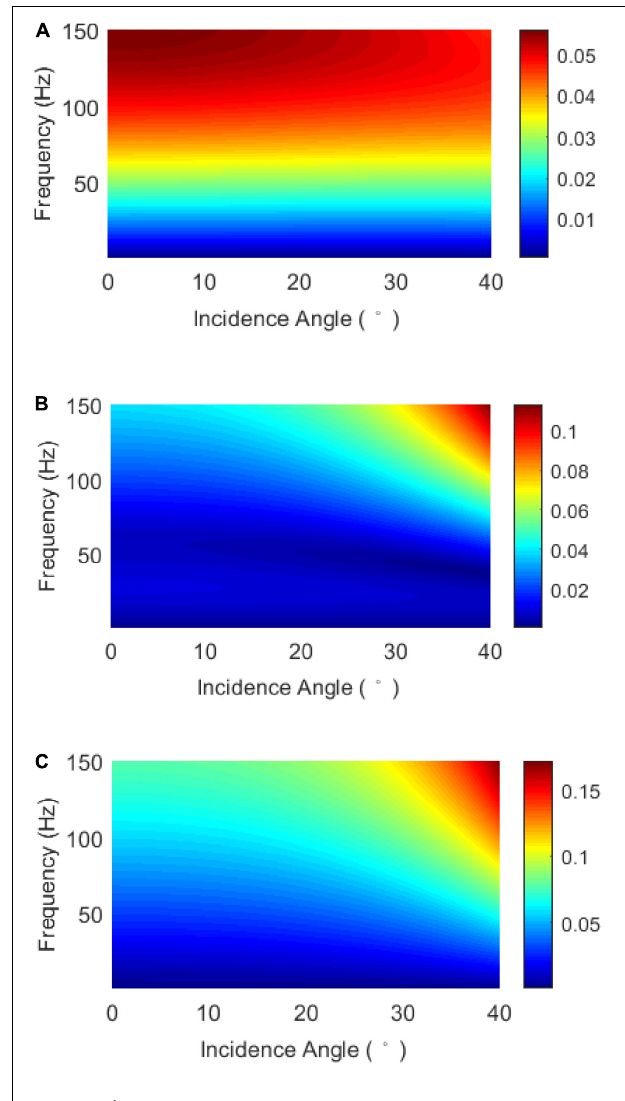
The Frequency-Dependent AVO